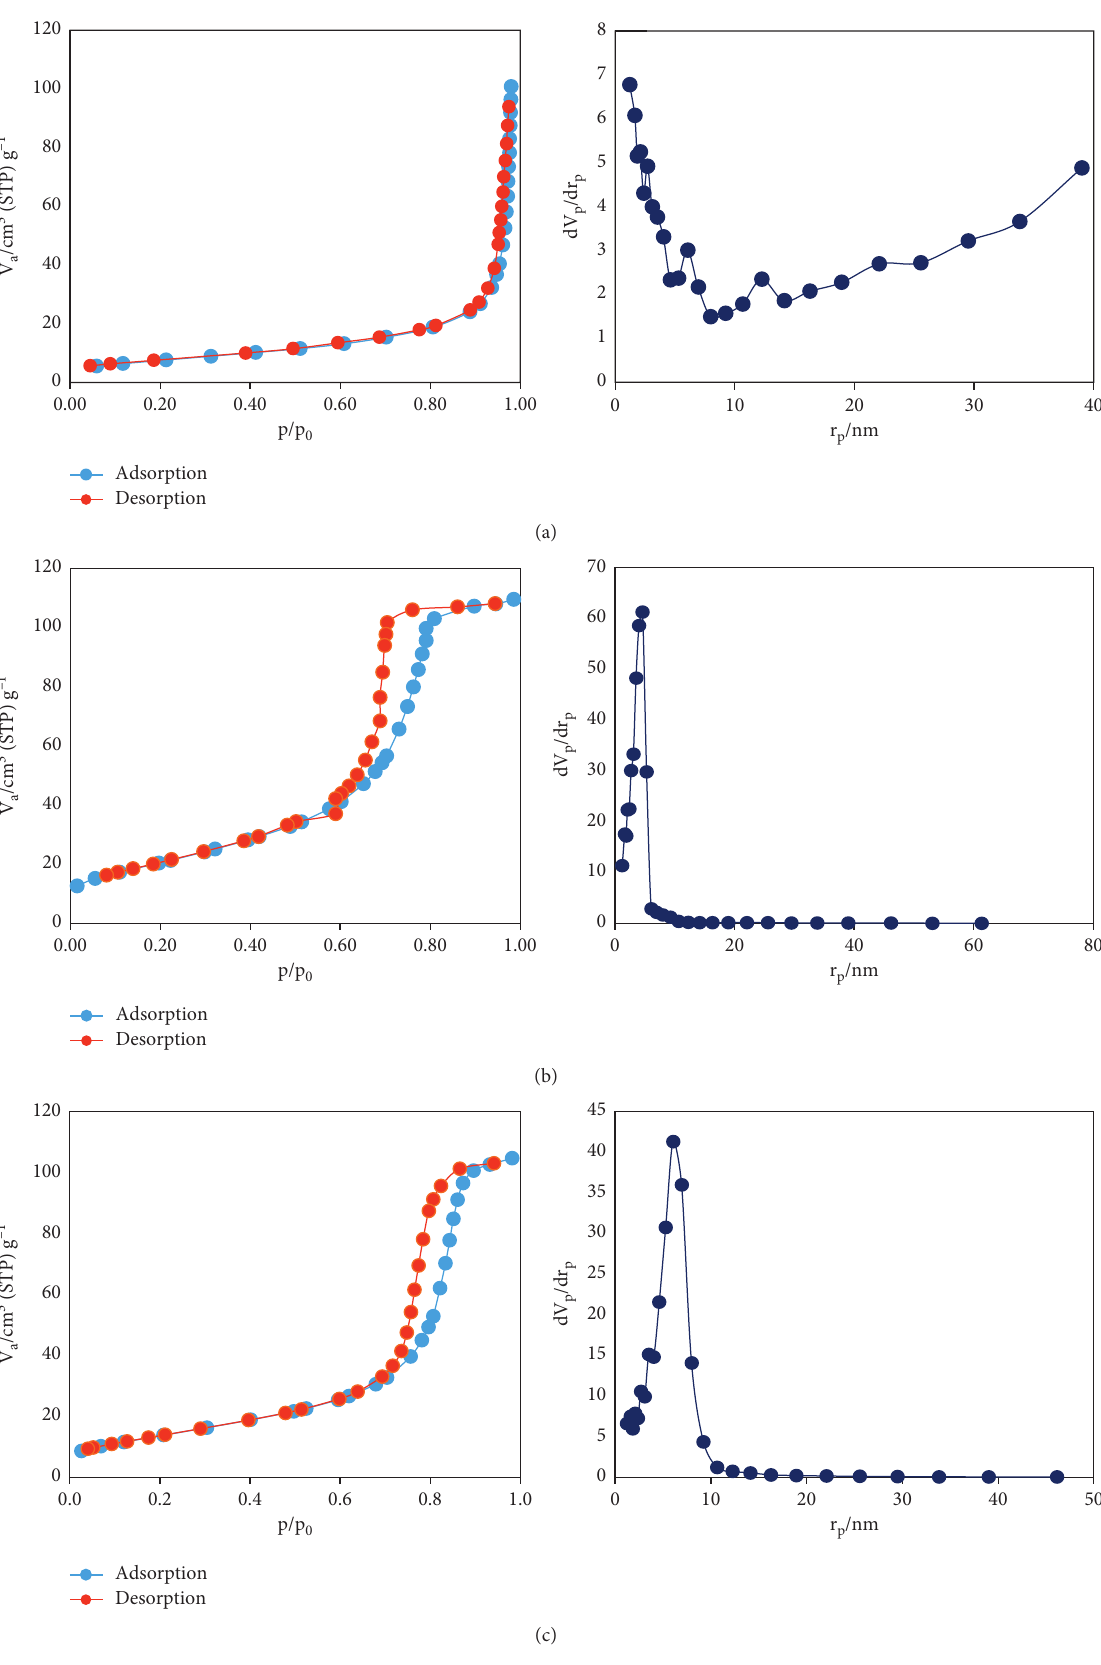
Figure 5: N2 adsorption and desorption curves and pore size distributions of (a) CNs, (b) N-CNs, and (c)